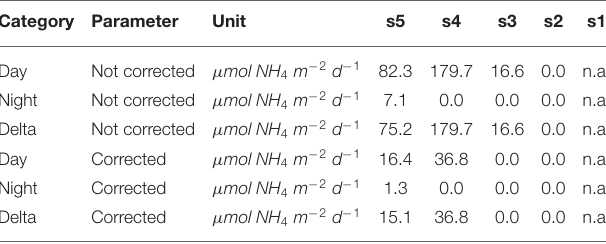
TABLE 5 | Integrated ammonium excretion rates of Euphausiacea for the 200–400m depth level. A 12h residence time in this layer at daytime was